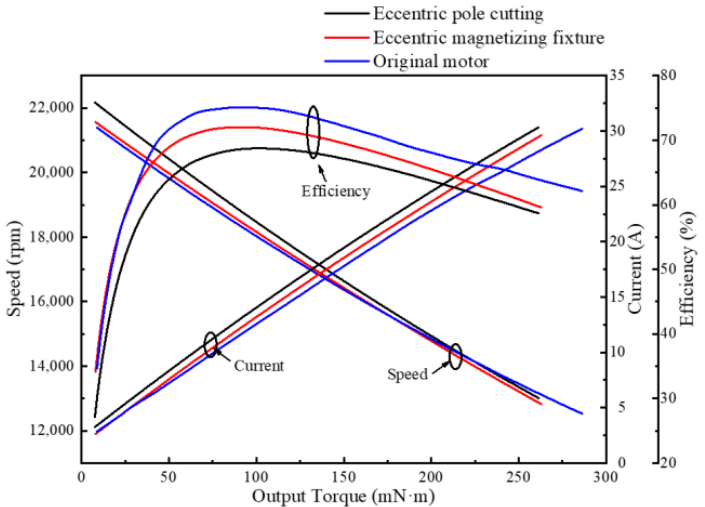
Figure 19. Motor performance curve comparison.